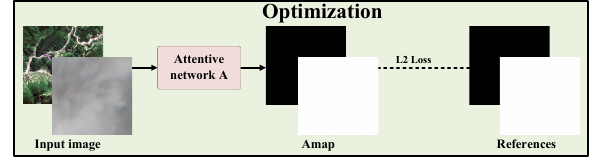
Figure 4. Optimization process of Attention